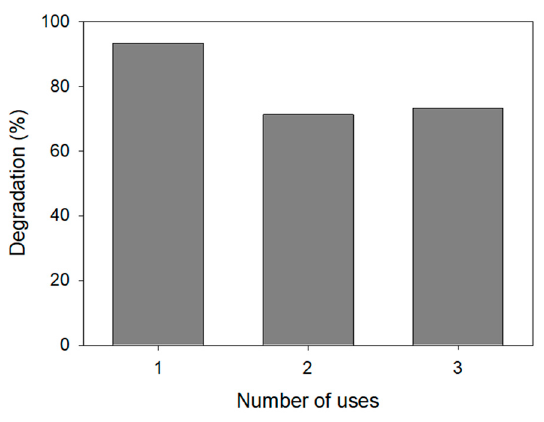
Figure 14. Degradation as a function of the number of uses of the nanocatalyst.